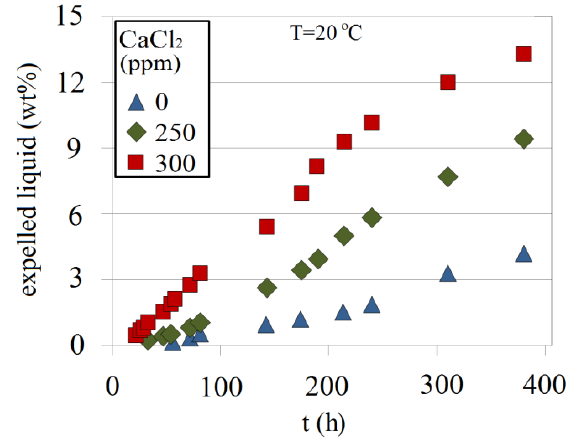
concentrations. 2